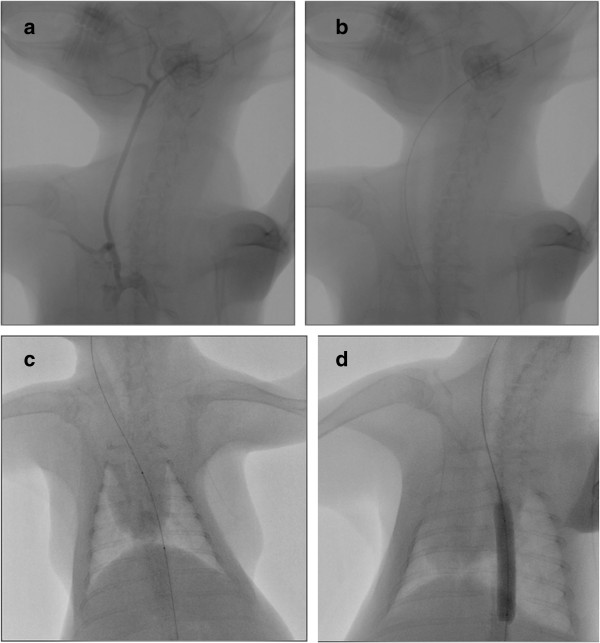
Balloon angioplasty of descending thoracic aorta. a. Roadmap images of the rabbit’s carotid artery and the thoracic aorta, b. Insertion of the guide wire into the descending thoracic aorta, c. Insertion of a 6.0-mm/40-mm peripheral dilatation balloon catheter over the guide wire and placement to the level of descending thoracic aorta d. Inflation of the balloon and injury of the descending aorta below the orifice of subclavian artery.